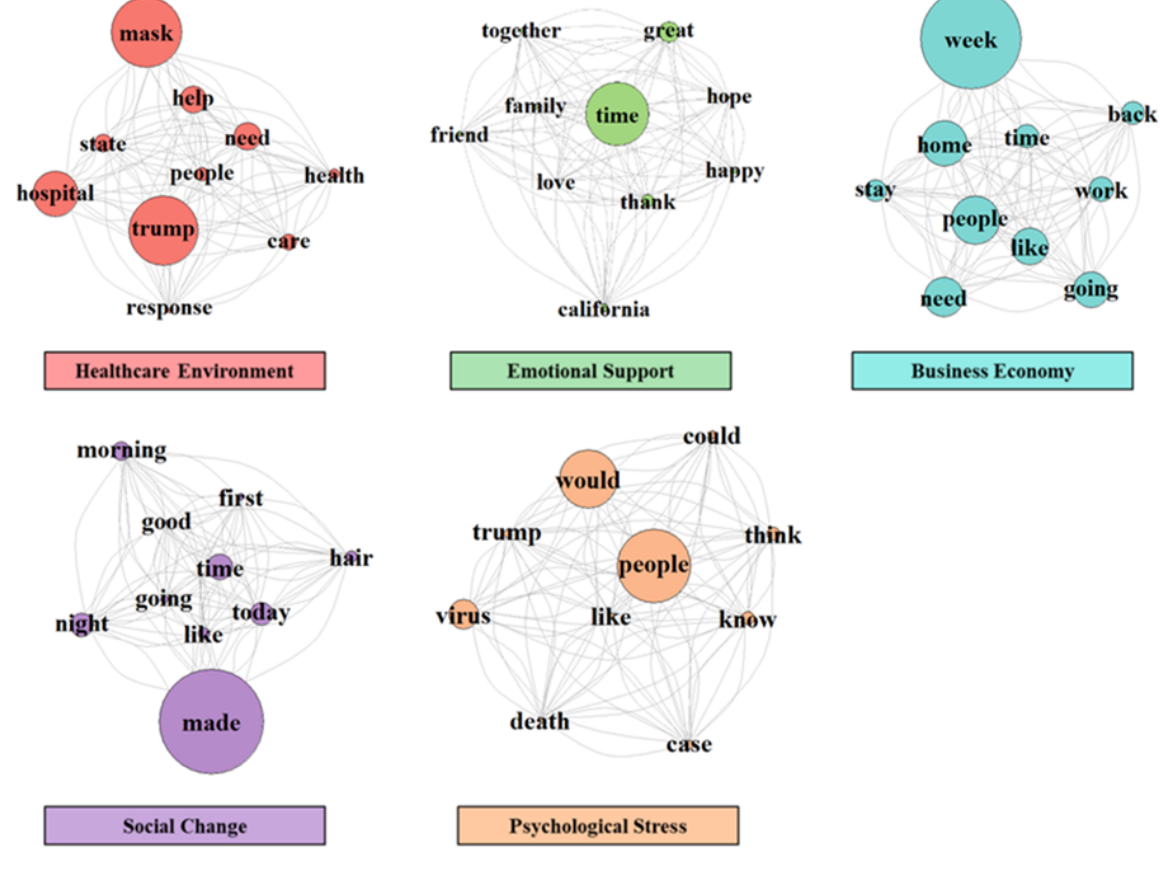
Figure 4. Social network graphs of the dominant topics about coronavirus disease (COVID-19), with the top 10 associated words per topic. The size of the node is proportional to the weight of the